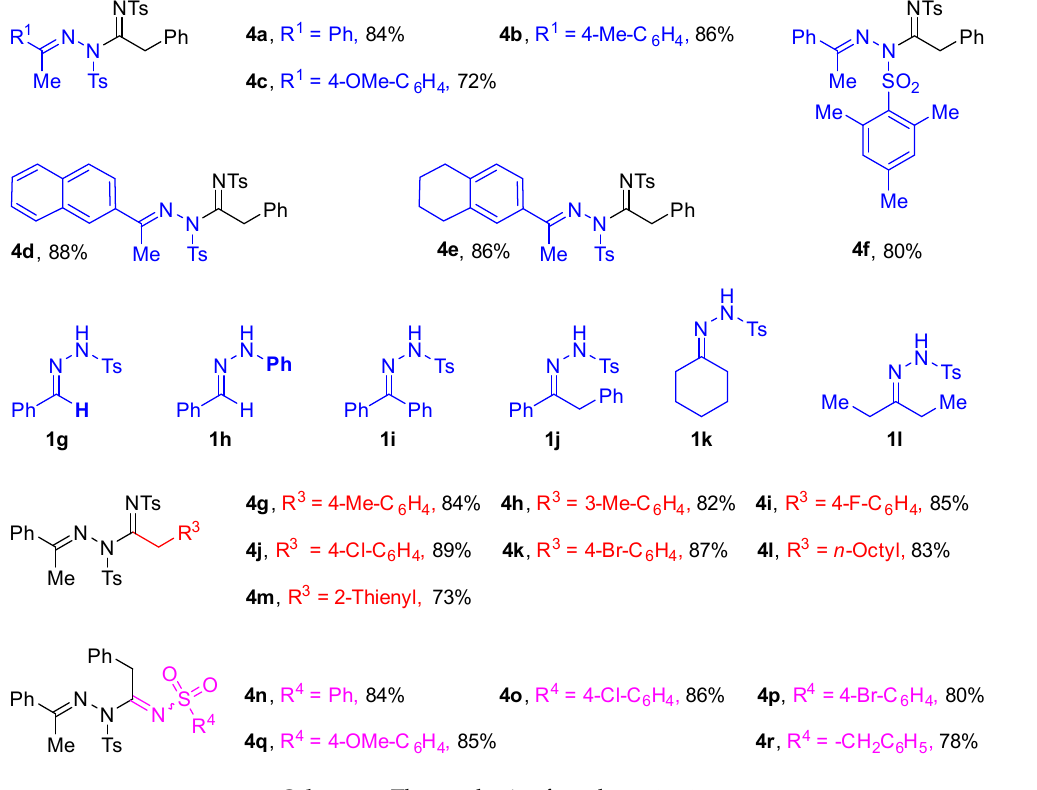
Scheme 2. The synthesis of products 4a – 4r.